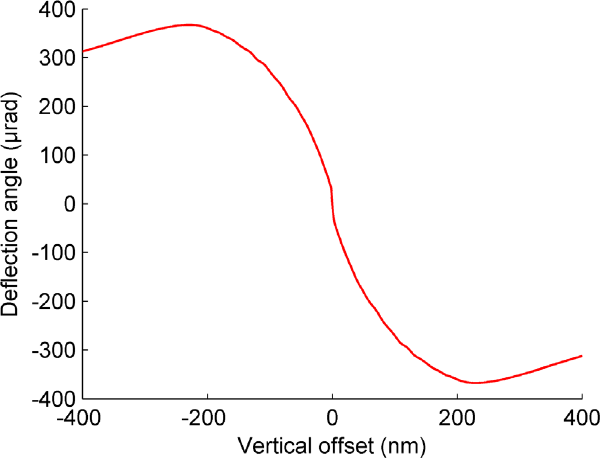
FIG. 3. Outgoing beam deflection angle versus incoming relative beam position offset at the IP for the ILC baseline design at 500 GeV c.m.